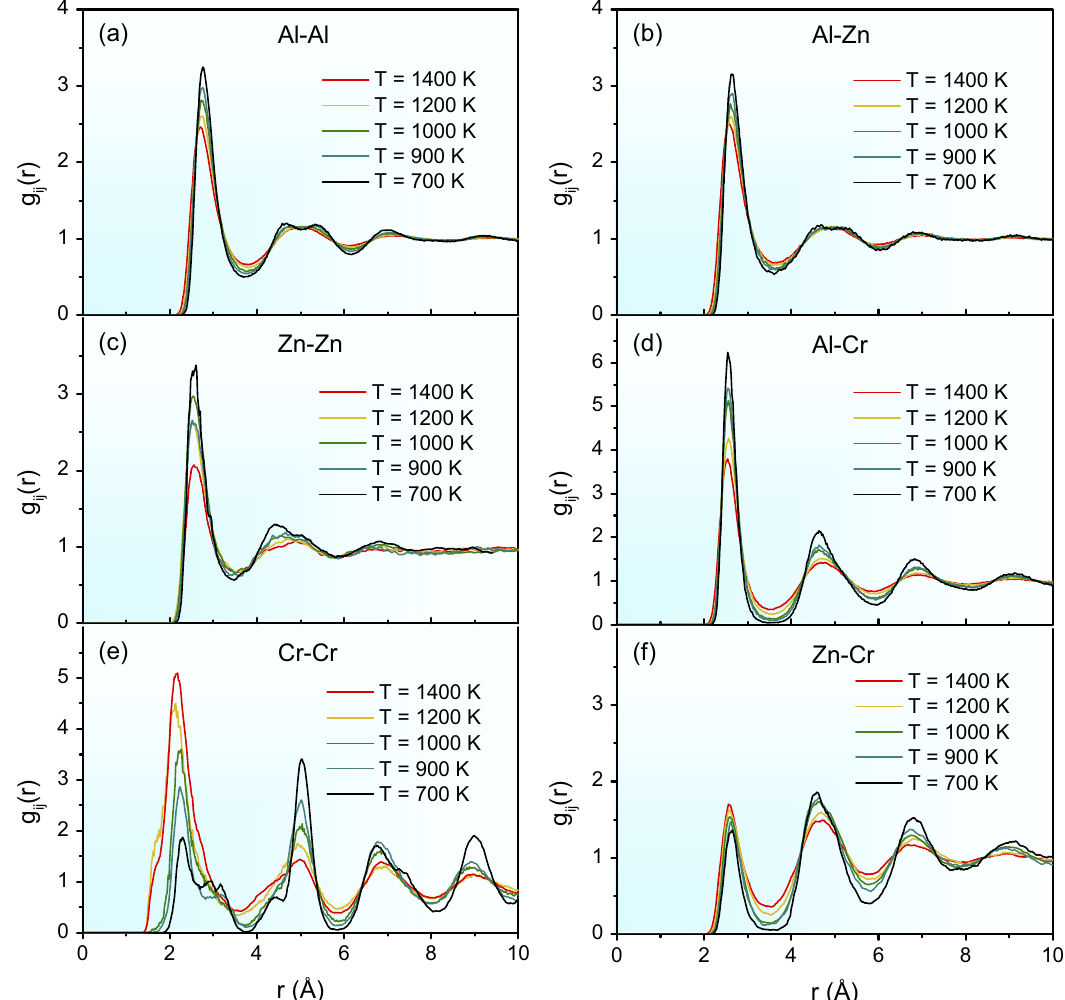
Fig. 6 Calculated partial pair-distribution functions of Al − Zn − Cr ternary alloy from ab initio molecular dynamics simulations for various temperatures: a Al − Al, b Al − Zn, c Zn − Zn, d Al − Cr, e Cr − Cr, and f Zn − Cr